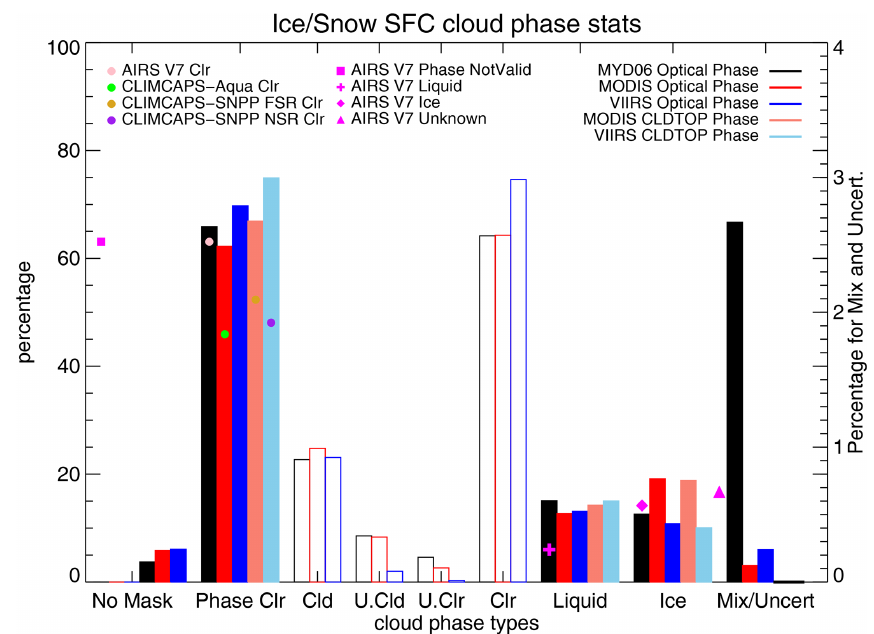
Figure 18. Similar to Figs. 15–17, except showing results calculated using data over snow- and ice-covered surfaces. Sounder retrieved surface classes are used to identify